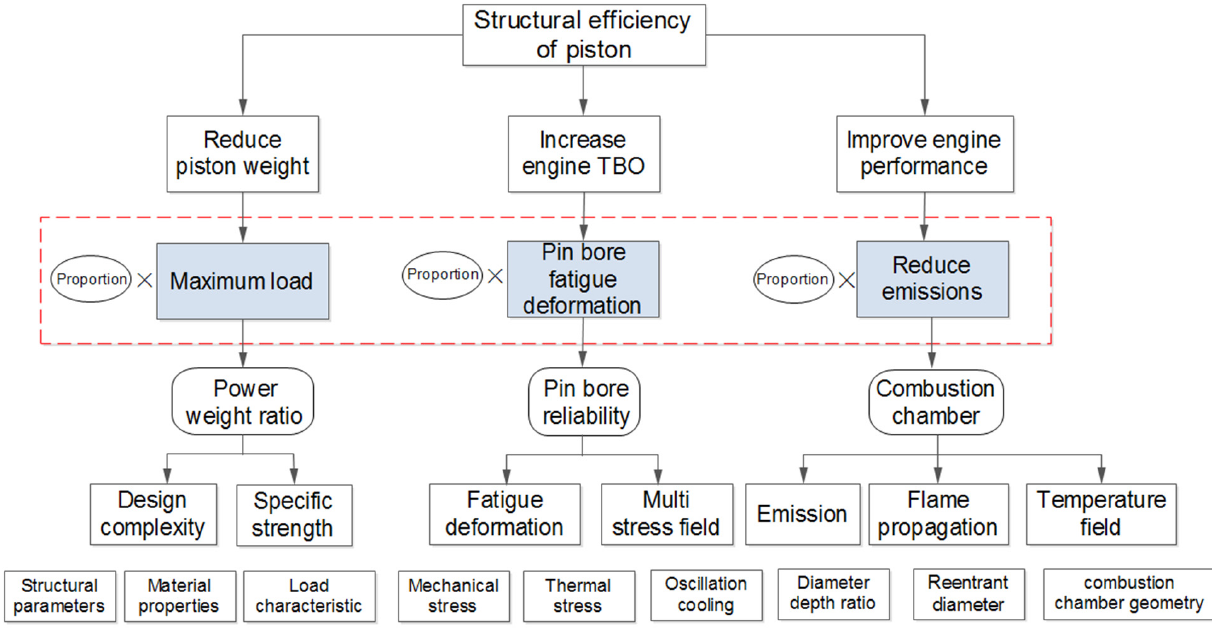
Figure 1. Piston structural efficiency analysis.